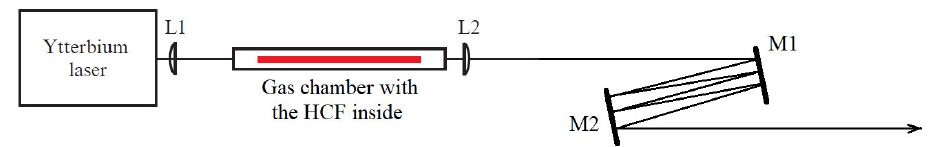
Figure 1. The scheme of the experimental setup. L1, L2—lenses. M1, M2—chirped mirrors. Red line is the HCF placed inside a gas chamber.